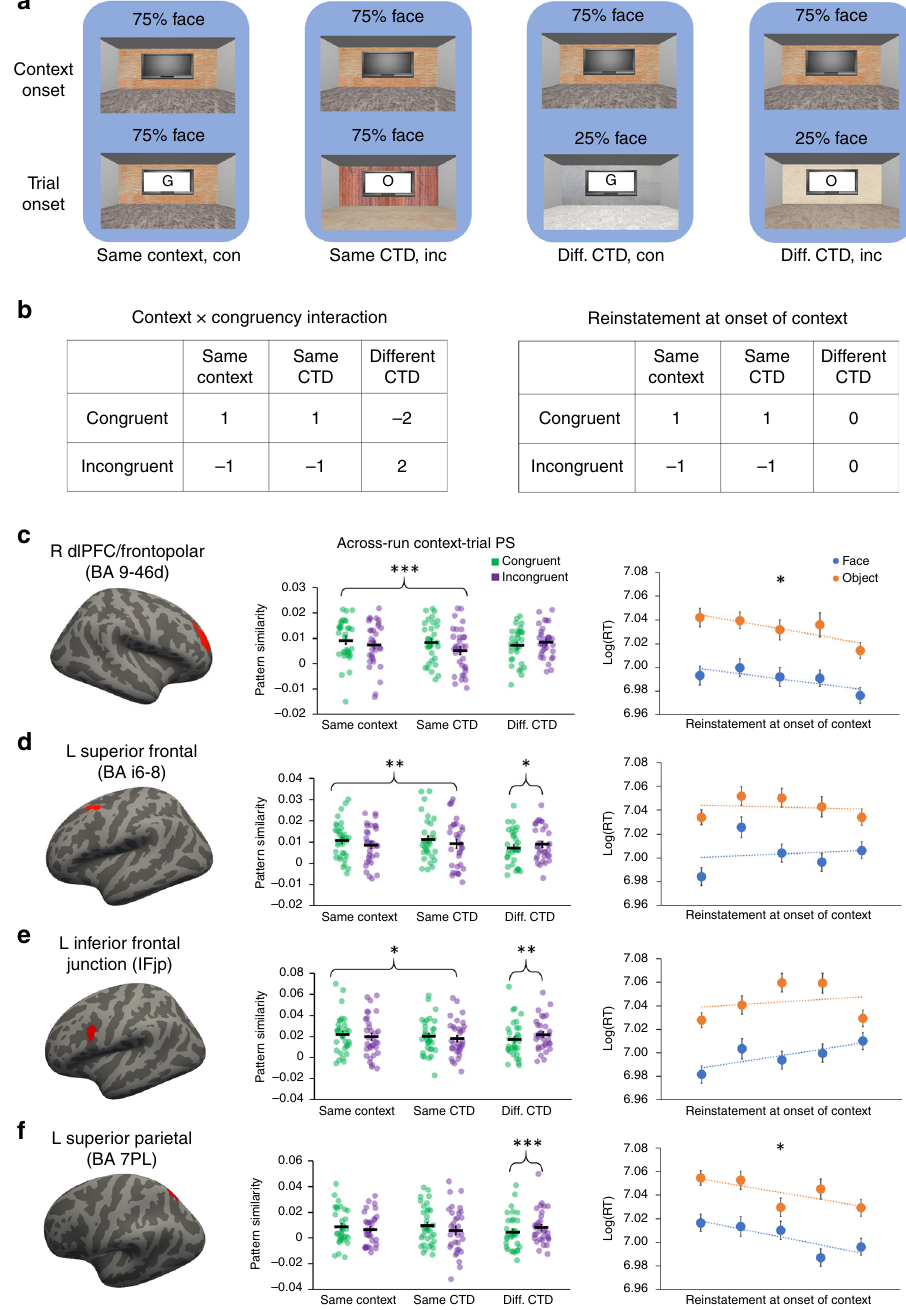
Fig. 4 Frontoparietal reinstatement of CTD. a Four examples (grouped by blue background) of how the CTD of context A (top row) and the required task and the CTD of a trial in context B (bottom row) de fi ne the experimental condition for testing the reinstatement of CTD (text label below the background). b Left: linear contrast testing the reinstatement of CTD. To account for different frequencies of trial types and to make the contrast orthogonal to main effects, the weight for Different CTD conditions was twice the weight for Same Context and Same CTD conditions. Right: contrast used to test the modulation of CTD reinstatement on RT. c – f Frontoparietal ROIs showing signi fi cant reinstatement of CTD. From left to right: locations of ROI (marked in red), Individual data and mean±SEM of context-trial pattern similarity plotted as a function of experimental conditions, quintiles ( x -axis) of group mean of log-transformed RT (±SEM) plotted as a function of task type and context-trial pattern similarity. The names of the ROIs are from the Human Connectome Project ’ s multi-modal cortical parcellation 32 . * p <0.05; ** p <0.01; *** p <0.001 (two-sided one-sample t -tests). con, congruent; inc, incongruent. For bar graphs, see Table 1 for P values. The experiment was conducted once ( n = 33 biologically independent samples). Source data are provided as a Source Data fi